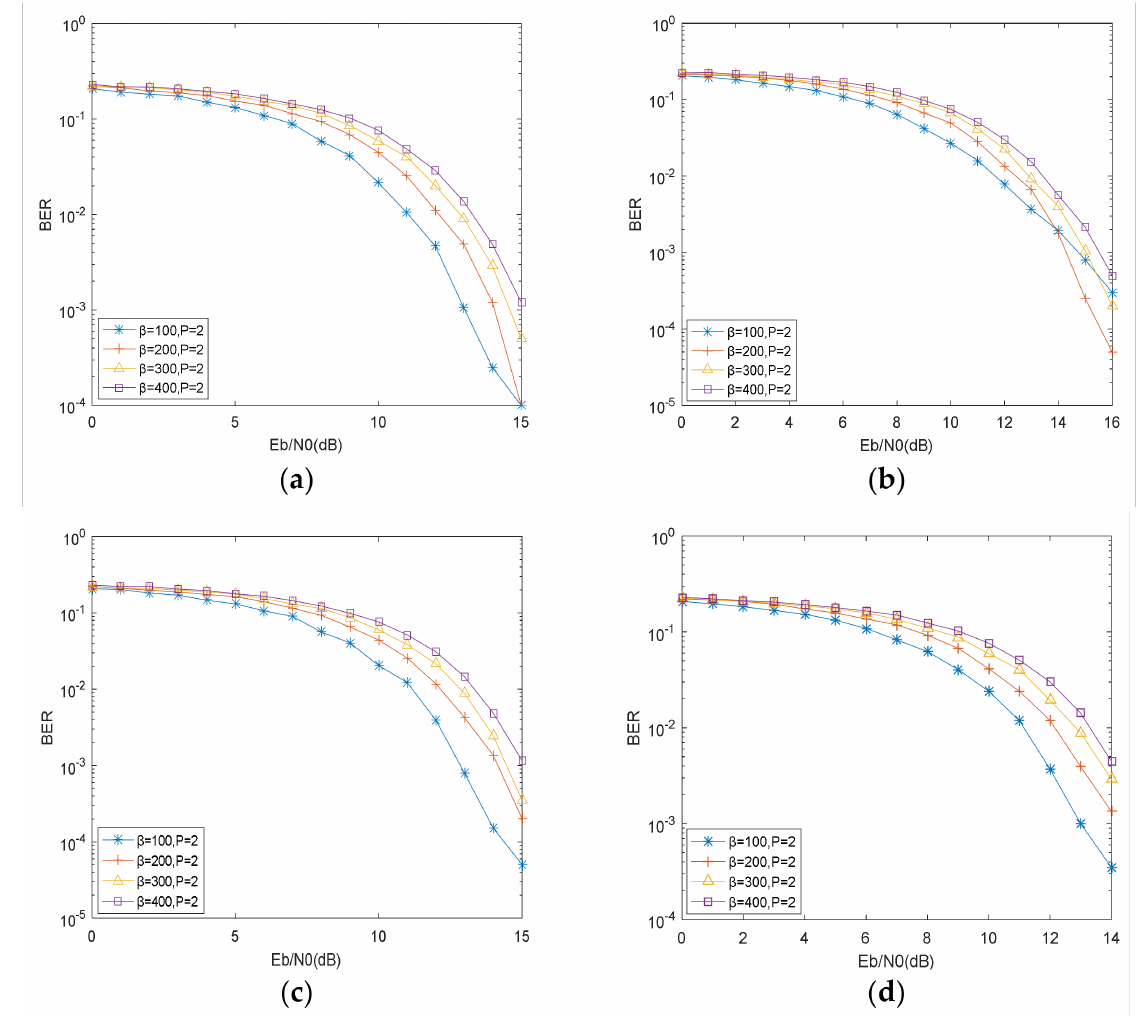
Figure 8. The BER perform of different half-amplification factor. ( a ) Sine mapping; ( b ) tent mapping; ( c ) circle mapping; ( d ) improved logistic